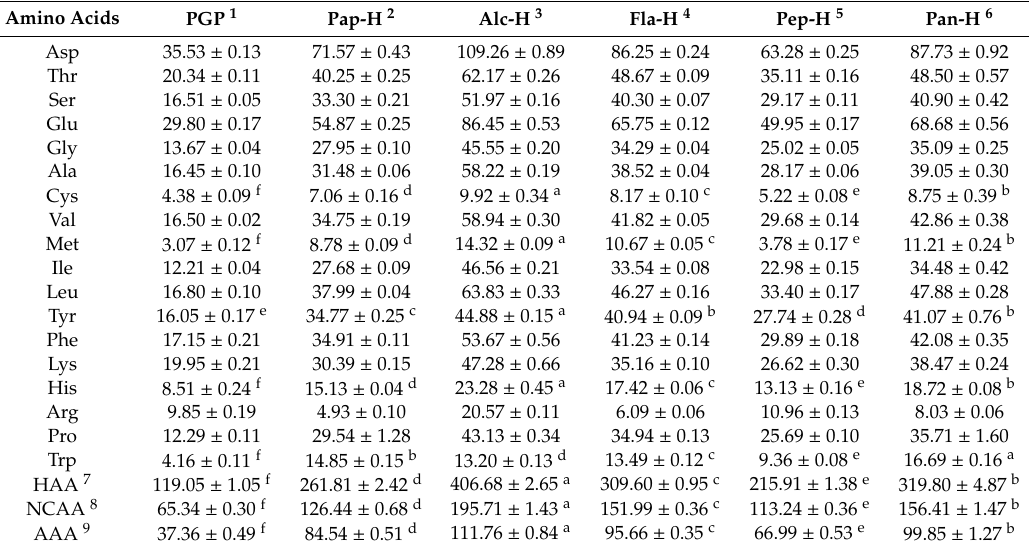
Table 1. Amino acid composition of PGP and its hydrolysates (mg / 100